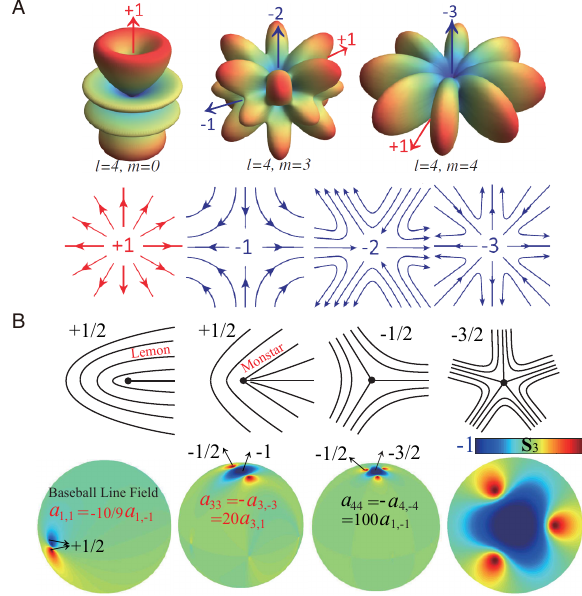
Figure 2: (A) (Up) intensity null points in far-field radiation patterns of individual multipoles. (Down) examples of polarization singular- ities in the instantaneous vector fields of multipoles. (B) (Up) ex- amples of polarization singularities in the polarization fields of compositemultipoles.(Down)existenceofpolarizationsingularities with half-integer Hopf indices in their polarization fields. (A) is adapted from [66] while (B) is adapted from